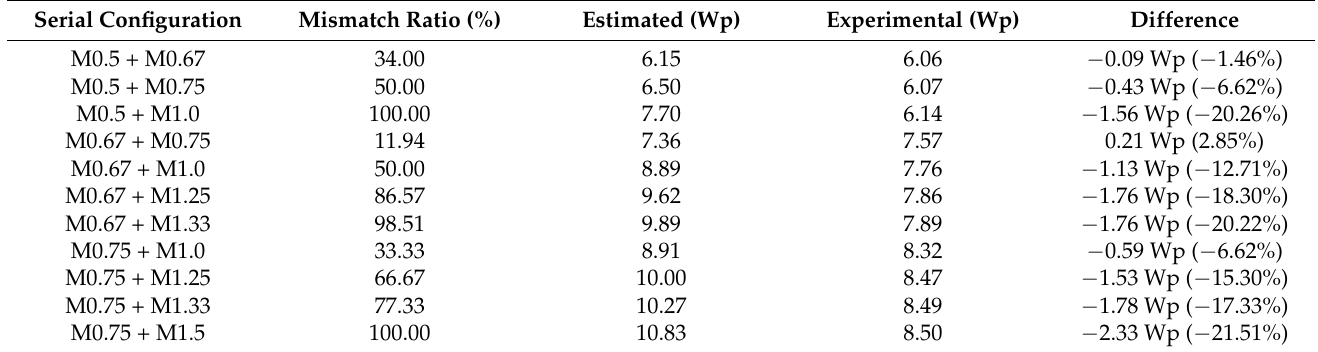
Table 9. The difference between the estimated and experimental value in each case I (<M1.0).